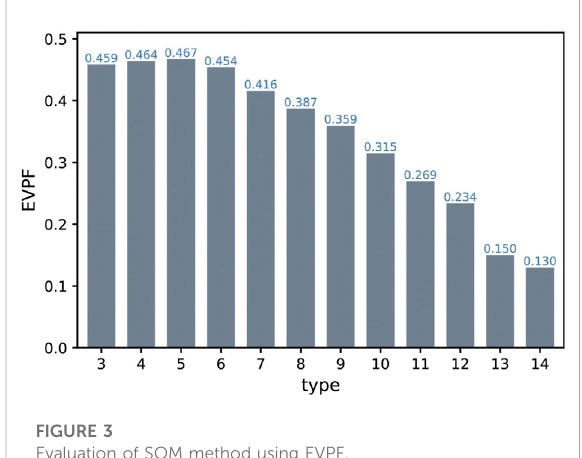
FIGURE 3 Evaluation of SOM method using EVPF.